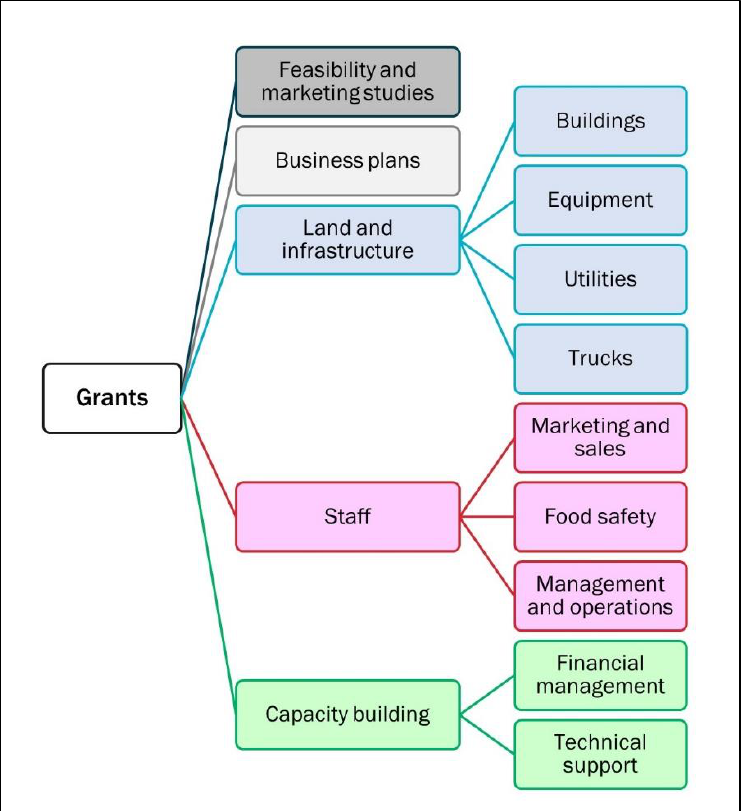
Figure 2. The Role of Grants in Cooperative and Nonprofit Food Hub